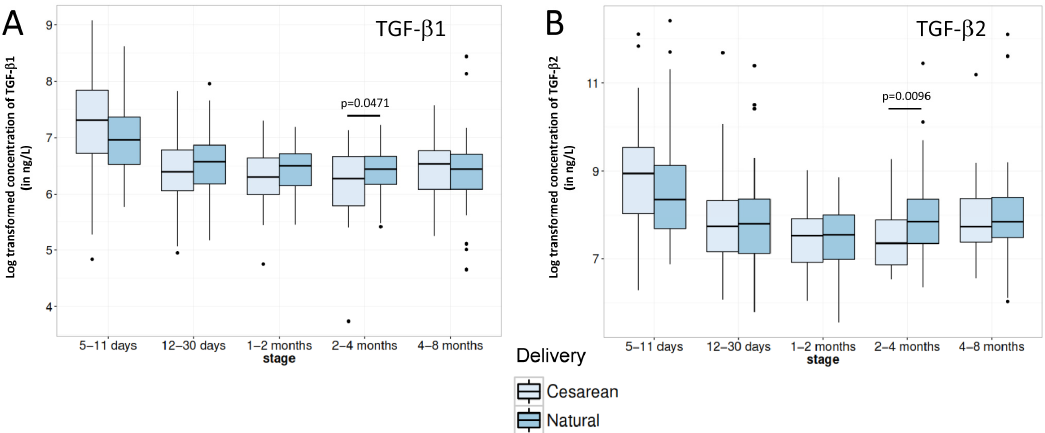
Figure 4. Comparison of ( A ) TGF ‐β 1 and ( B ) TGF ‐β 2 contents in breast milk from mothers delivering their infant either vaginally (Natural) or by Caesarean section for each lactation period of this study. Box plot represent medians with 25th and 75th percentile, min ‐ max range and outliers. Statistical significance was set at p < 0.05 and significant p ‐ values are indicated in the graphs.